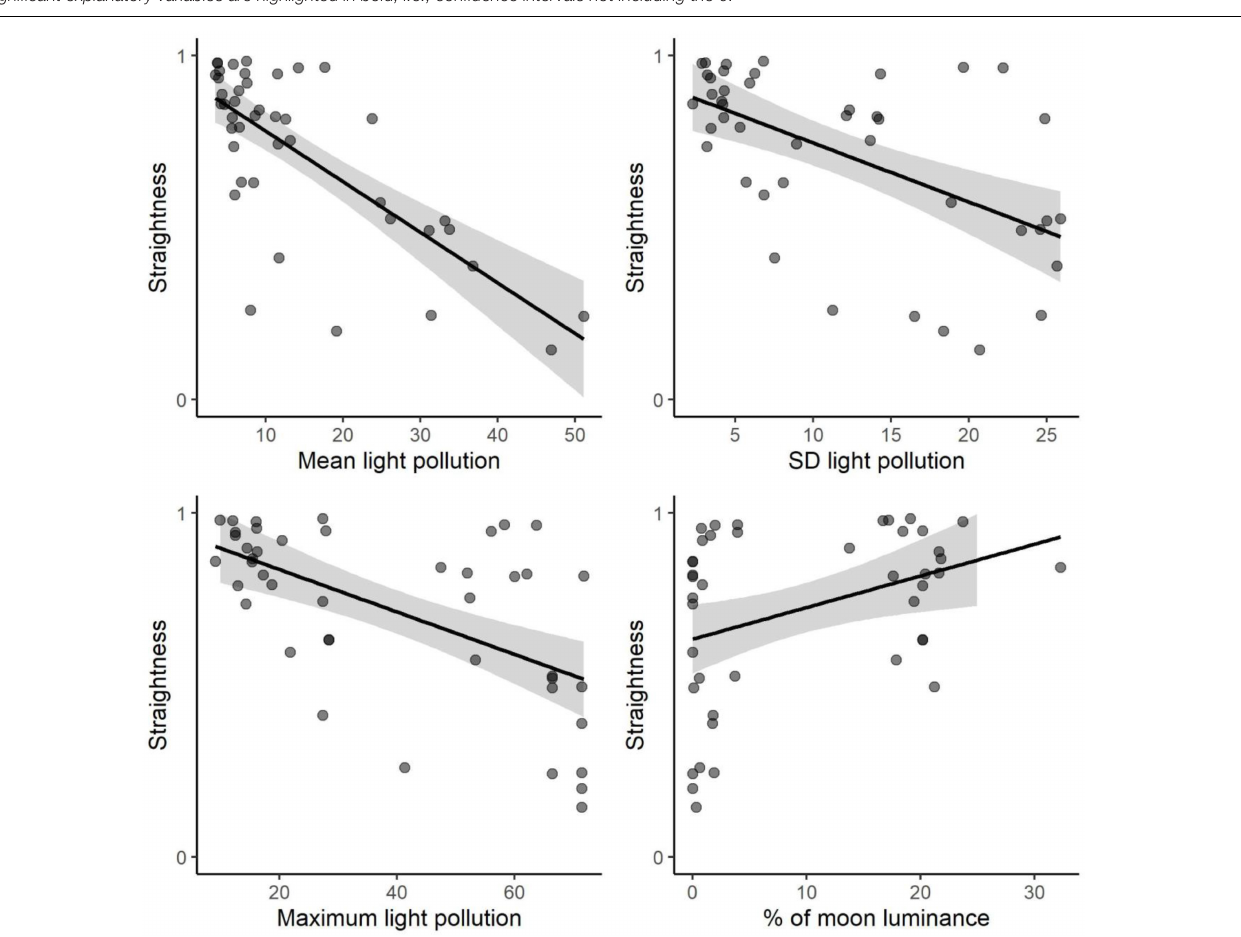
FIGURE 3 | Relationships between flight straightness (calculated as the ratio between straight distance and flight distance) and significantly correlated variables according to the linear models (see Table 5 ). Black lines and grey areas indicate the predicted effects and the 95% confidence intervals of univariate linear models ( Table 5